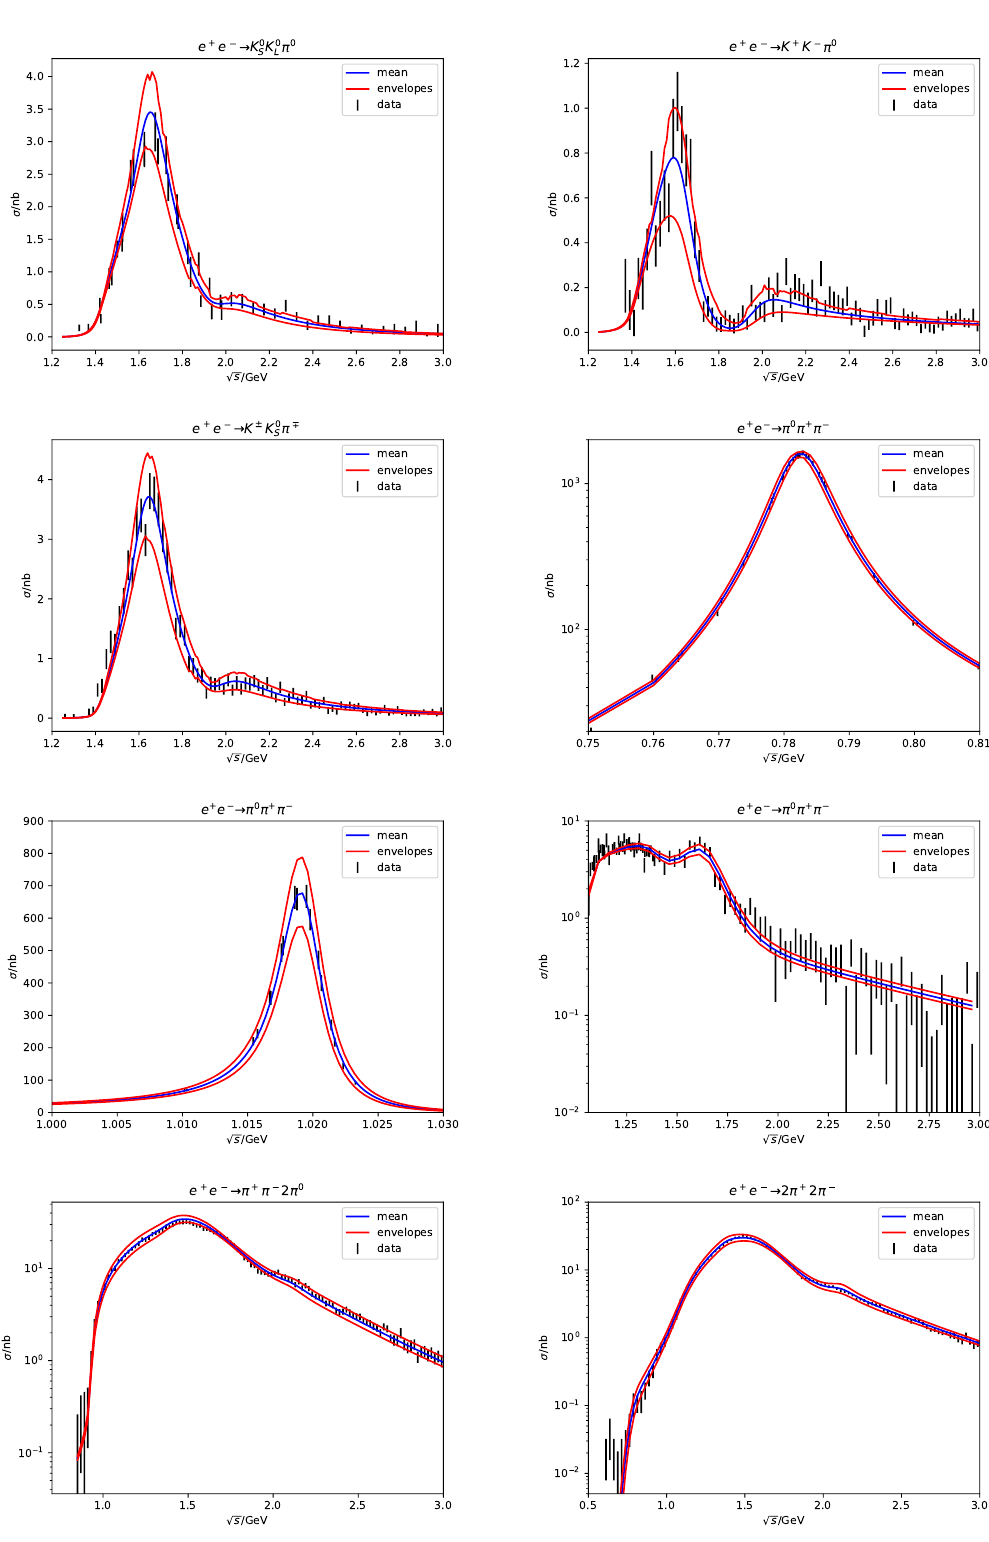
Figure 8: cross sections for hadronic final states with error